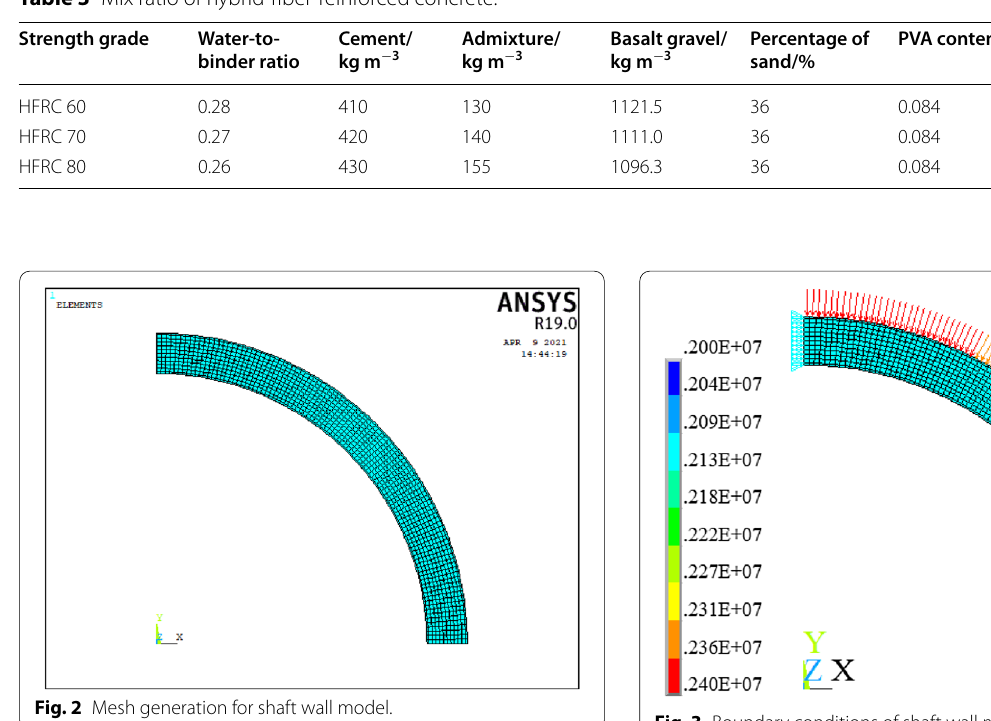
Fig. 3 Boundary conditions of shaft wall